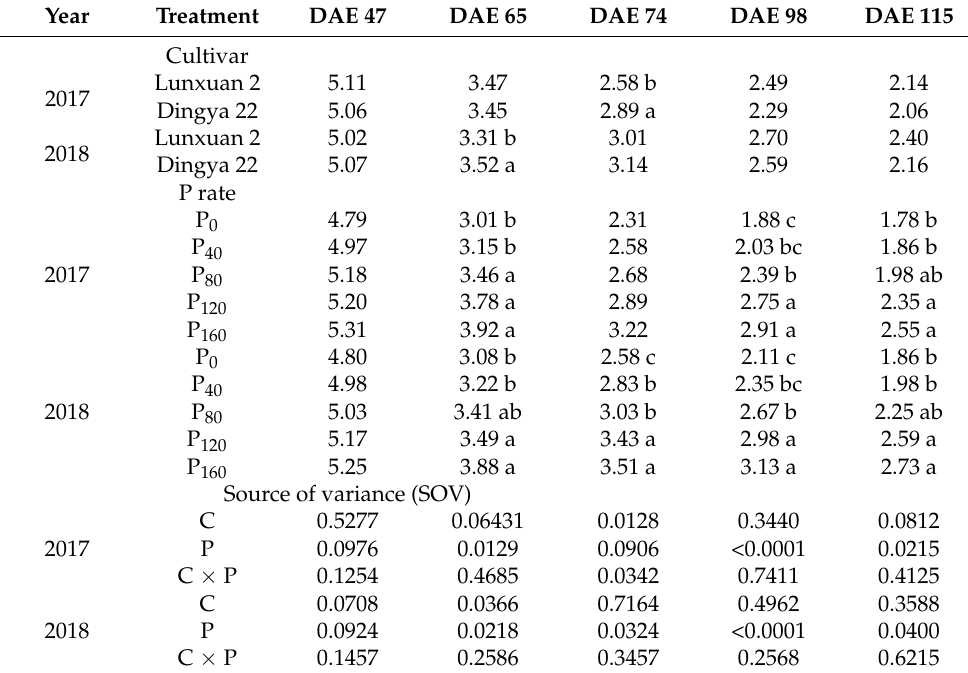
Table 3. Shoot P concentration (g kg − 1 DM) at Dingxi in 2017 and 2018 with two cultivars flax and five phosphorus